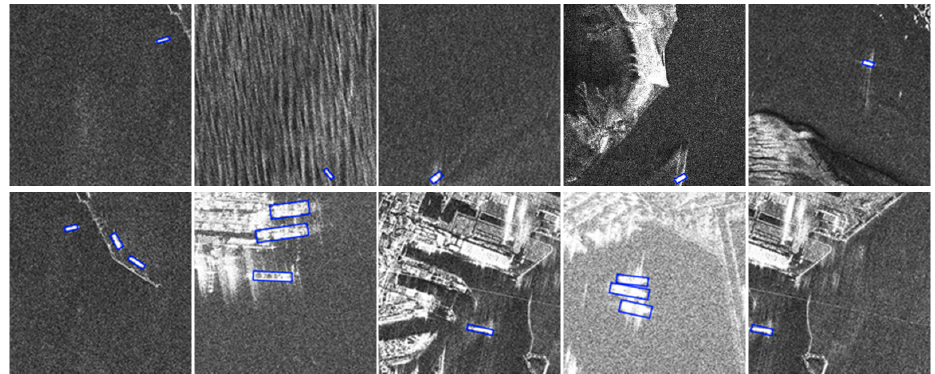
Figure 16. Satisfactory detection results on the AIR-SARShip dataset. Both small ships and ships in complex backgrounds can be detected correctly.